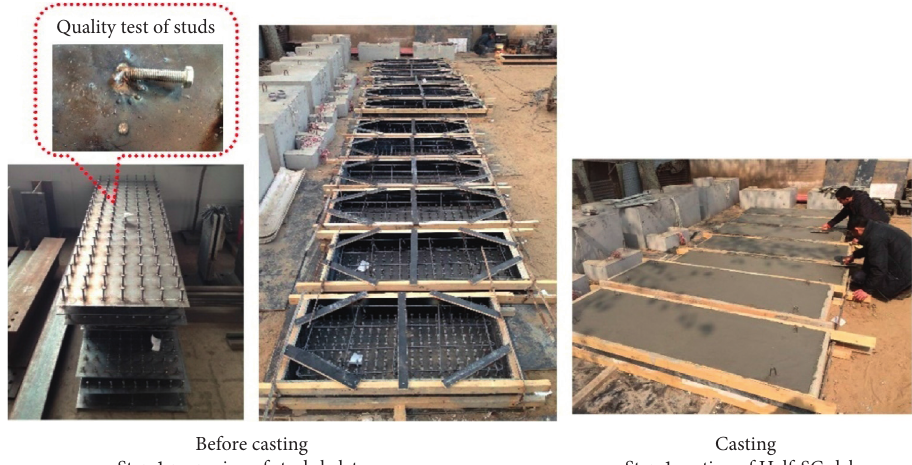
Figure 3: Details and fabrication of Half-SC